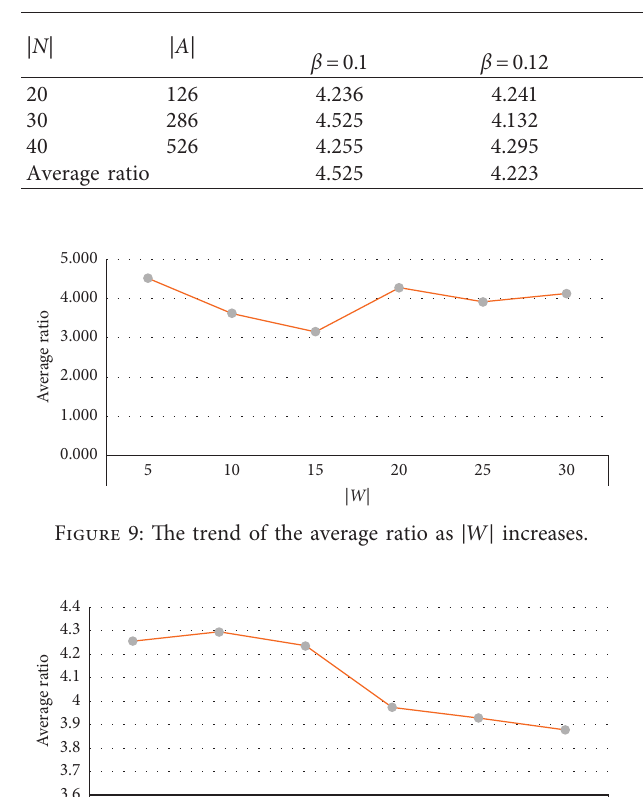
Table 11: Result of experiments with varied β , when | W |� 20, α � 0.1, and λ � 0.7.